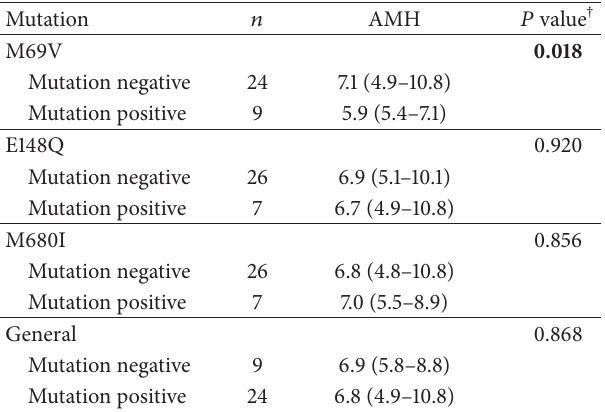
Table 4: AMH levels according to mutations in the FMF